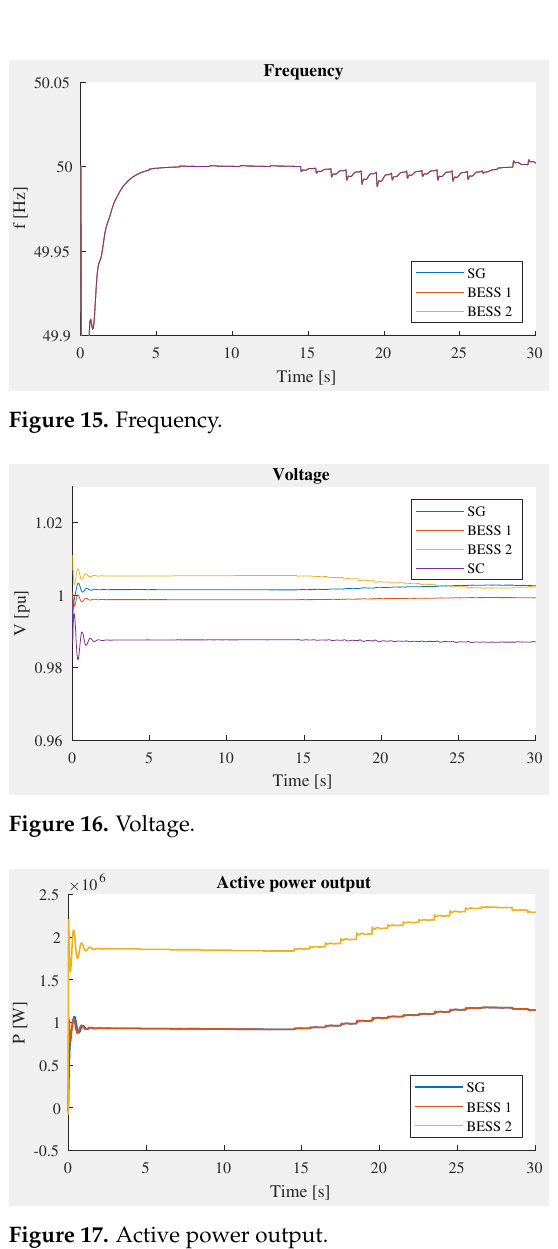
Figure 17. Active power output.